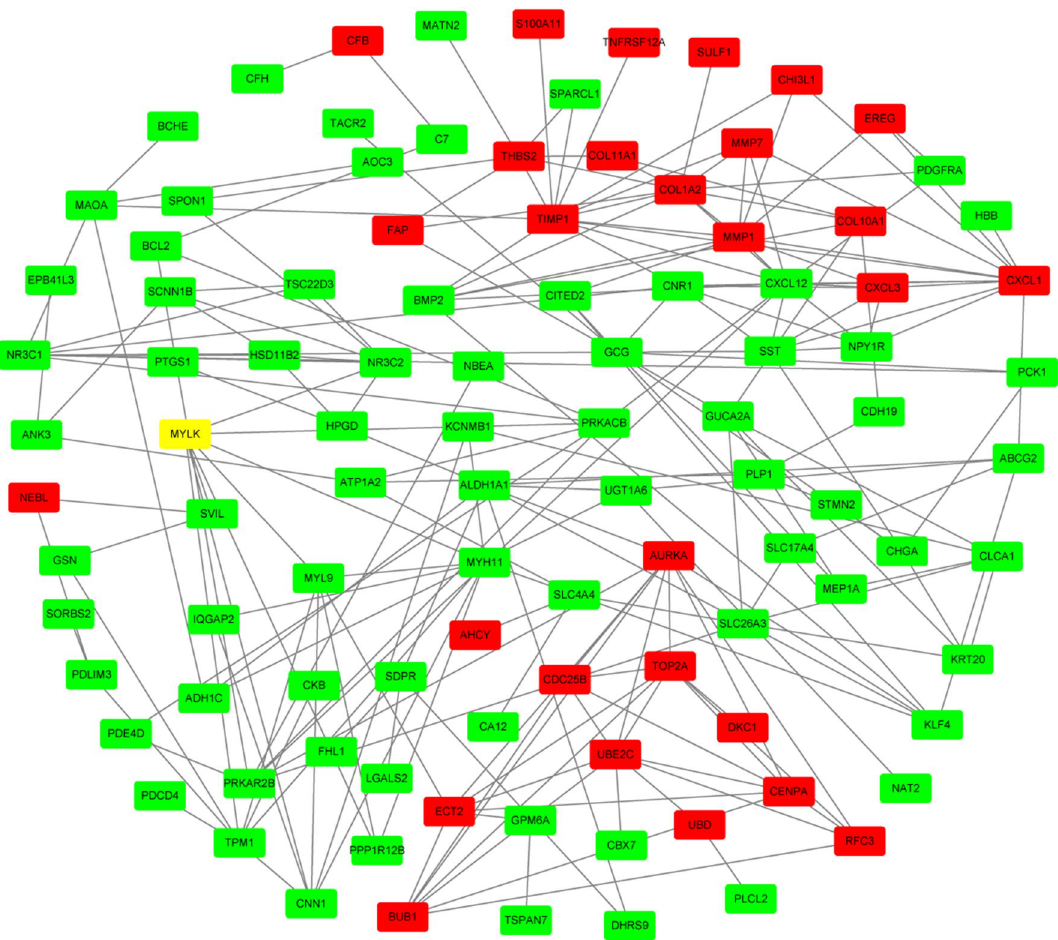
Figure 4. Protein–protein interaction network of proteins encoded by differentially expressed genes between primary tumor tissues and normal colon tissues. Red nodes represent upregulated genes; green nodes represent downregulated genes.